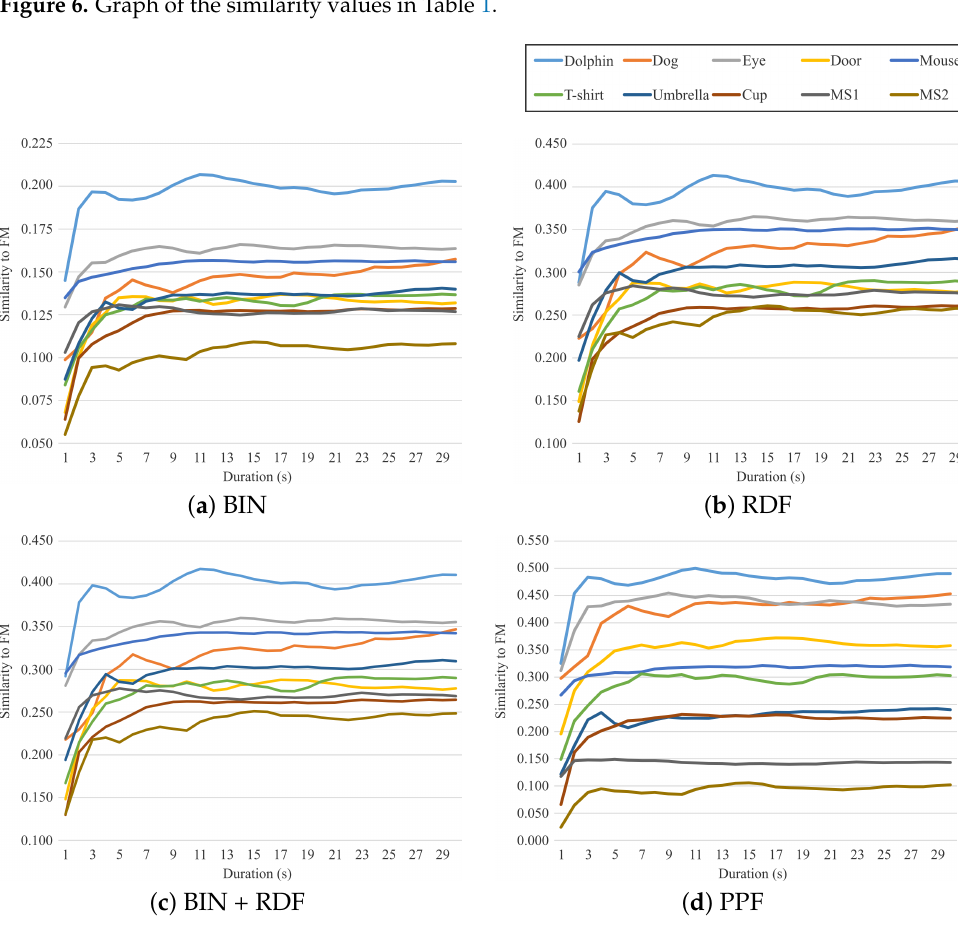
Figure 7. Similarity transitions during the viewing